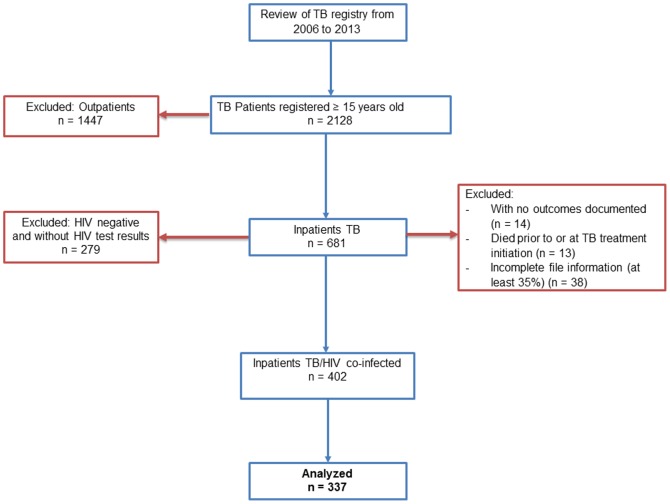
Enrollment of study participants.